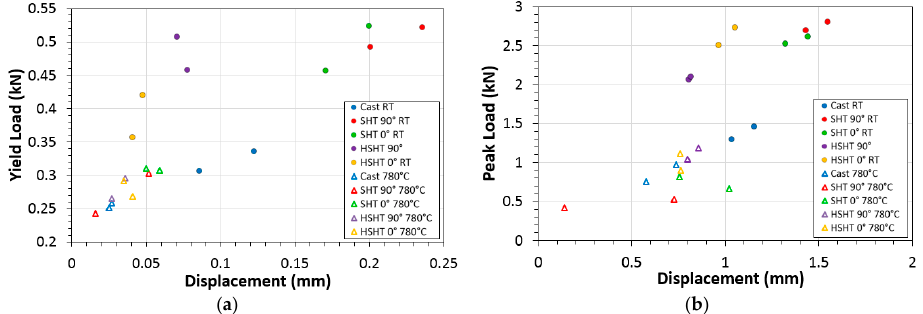
Figure 5. Summary of SPT data at RT and 780 °C including: ( a ) peak load–peak load displacement; ( b ) yield load–yield load displacement. ( b ) yield load–yield load